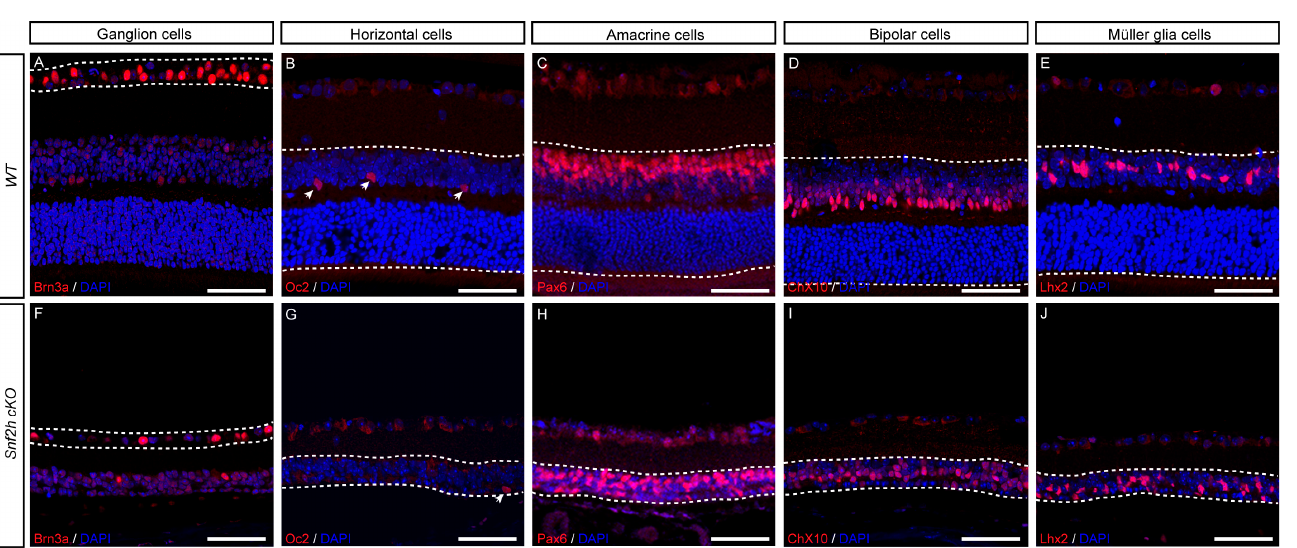
Figure 5. All cell types in GCL and INL are present in the Snf2h -deficient retina. GCs in the GCL were detected using anti-Brn3a antibodies in the P18 retina ( A , F ). The interneurons in INL of P18 ( B , D , E , G , I , J ) or P22 ( C , H ) were identified by the following molecular markers: Oc2 (HCs), Pax6 (ACs), Chx10 (BCs), and Lhx2 (MCs). Scale bars: 50 µm.